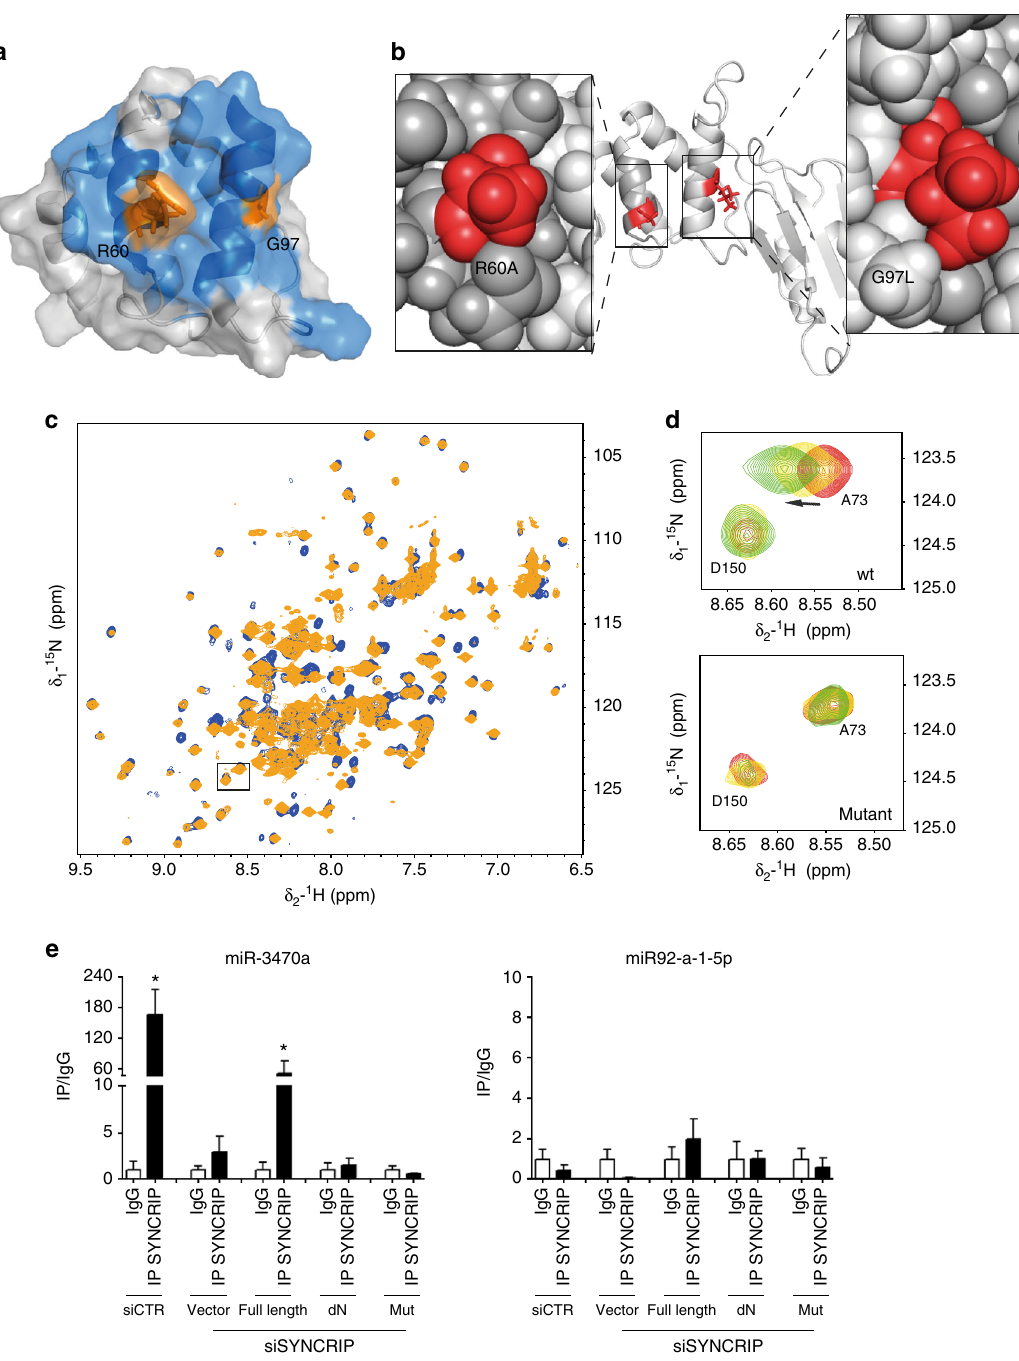
Fig. 8 Eliminating the RNA-binding activity of the NURR domain impairs Syncrip interaction with miR-3470 in the cell. a Surface representation of human Syncrip N-terminal domain, residues affected by RNA binding are coloured blue and the two mutated residues coloured orange. b Model of Syncrip NeR1 R60A G97L mutant. The side chains of residues A60 and L97 are coloured red. The central image shows a cartoon representation of the protein, the two side panels show the side chains of residues close to the mutations in space fi lling representation. The model was built using SwissMode, using the structure of the Drosophila NeR1 two-domain protein as template, as the G97 residue is close to the N-eR1 interface. c The R60A G97L double mutation does not change the structure of the protein but impairs RNA binding. (Left) Superimposition of the 15 N-correlation spectra of the wild-type (blue) and mutant (orange) NeR1 protein, showing that only minor changes are observed upon mutation and that the structure of the protein is conserved. d The R60A G97L double mutation eliminates RNA binding by the N-terminal domain. The changes in a representative peak of the wild-type (top) and mutant (bottom) proteins upon addition of a 1:1 and 1:2 ratio of hEXO RNA targets are displayed in this spectral superimposition. Peaks in the RNA-binding surface change upon titration of the RNA into the wild-type, but not the mutant protein. e RIP assays with anti-SYNCRIP antibody and, as control, preimmune IgG, on lysates from hepatocytes knocked-down for endogenous Syncrip by short-hairpin RNA (shRNAs) approach (shSyncrip). A scrambled shRNA was used as control (shCTR) as previously reported 10 . The cells were transduced with either an empty vector (Vector) or vectors overexpressing human WT Syncrip (full length), human Δ NURR (dNURR) and human mutant Syncrip (R60A-G97L). miRNA 3470a (left) and miRNA 92a-1-5p (right) (hEXO miRNA and non- hEXO miRNA, respectively) levels in immune-precipitated samples were determined by RT-qPCR and reported as IP/IgG. Data are means ± SEM of three independent experiments. Statistical signi fi cance was determined by parametric paired t -test analysis (* p <